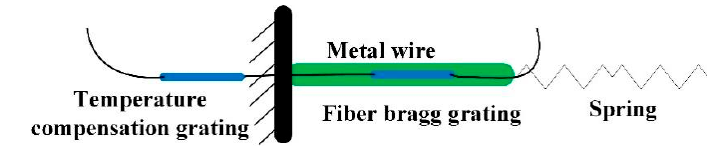
Figure 7. The fiber grating paste.